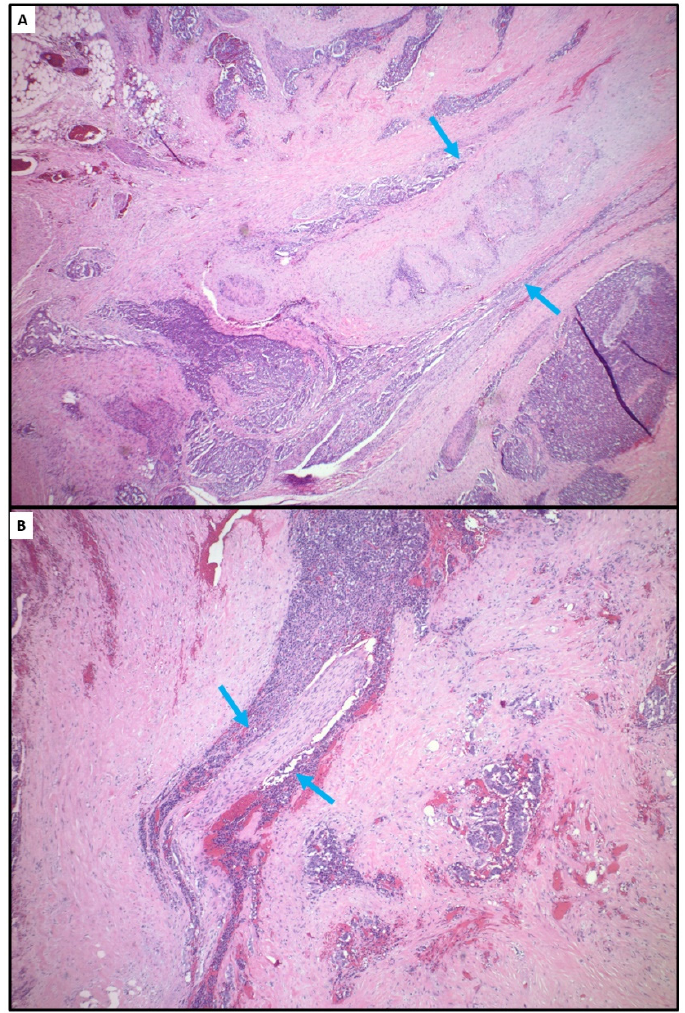
Figure 5. Representative sections of a mesenteric mass from a patient with small intestinal neuroen- docrine tumor showing extensive fibrosis. ( A ) Entrapped large mesenteric artery with elastosis (blue arrows). ( B ) Entrapped nerve bundle (blue arrows).